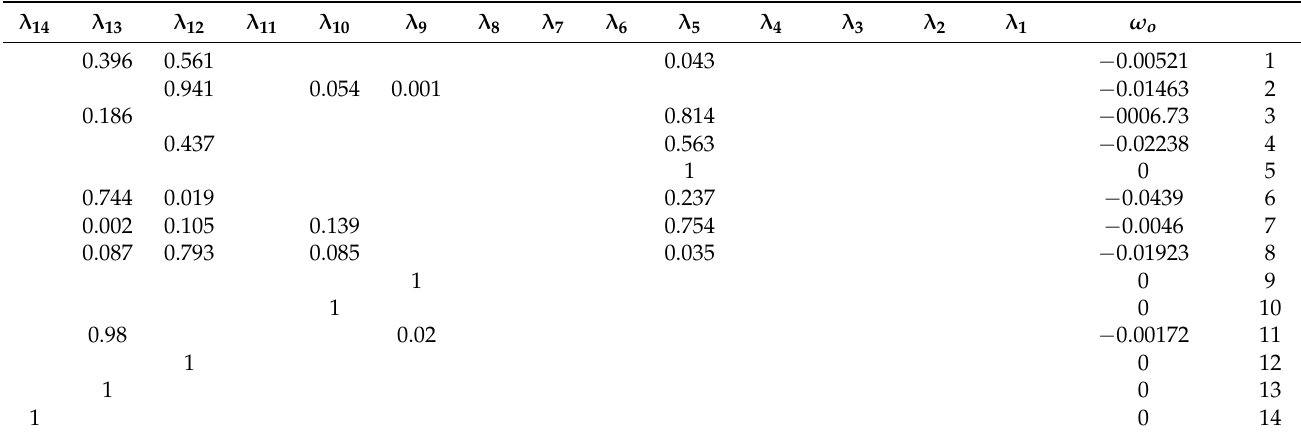
Table 4. The convex combination and the efficiency of